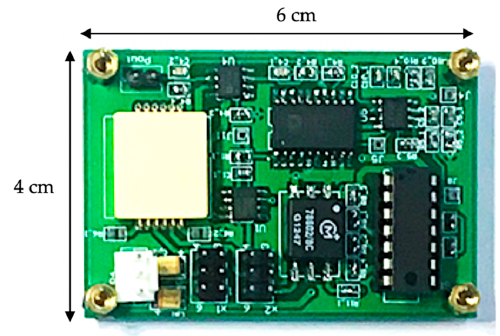
Figure 9. The accelerometer prototype on the signal conditioning circuit board.